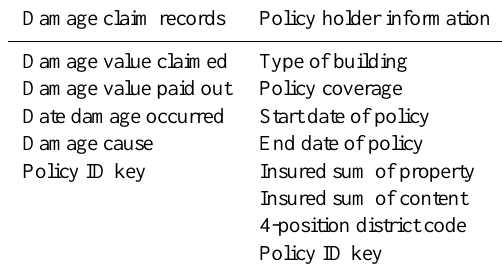
Table 3. A brief overview of variables recorded in insurance databases held by the Dutch Association of Insurers. The damage claim records can be linked to the policy holder information through the policy ID key.